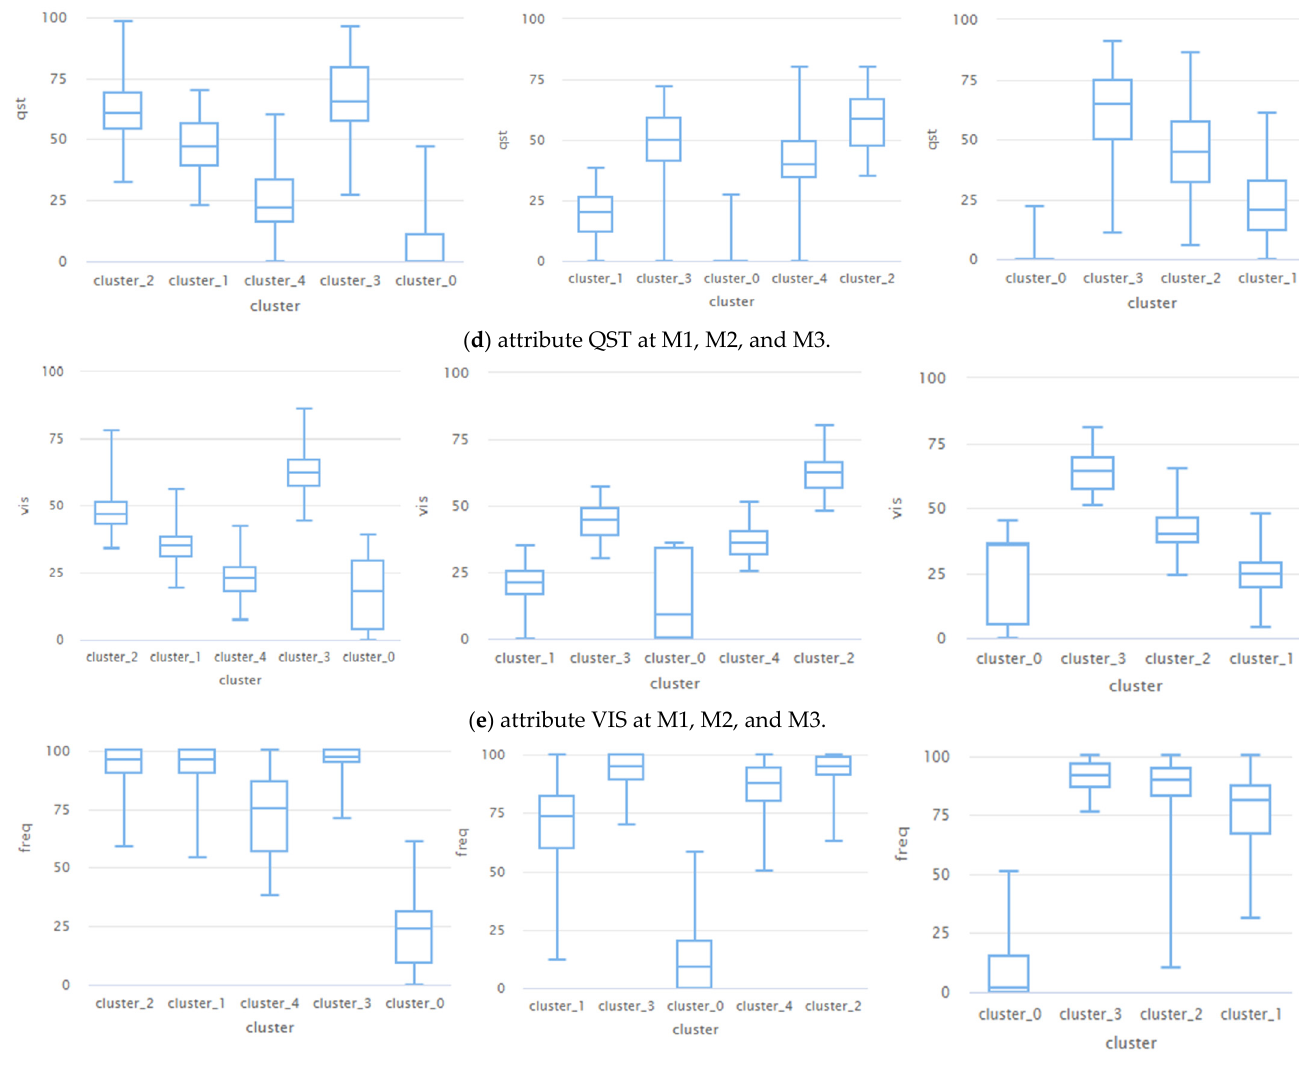
Figure 10. Boxplot by clusters in M1, M2 and M3 for each attribute; ( a ) UAA; ( b ) CIR; ( c ) pGPA; ( d ) QST; ( e ) VIS; ( f ) FREQ.